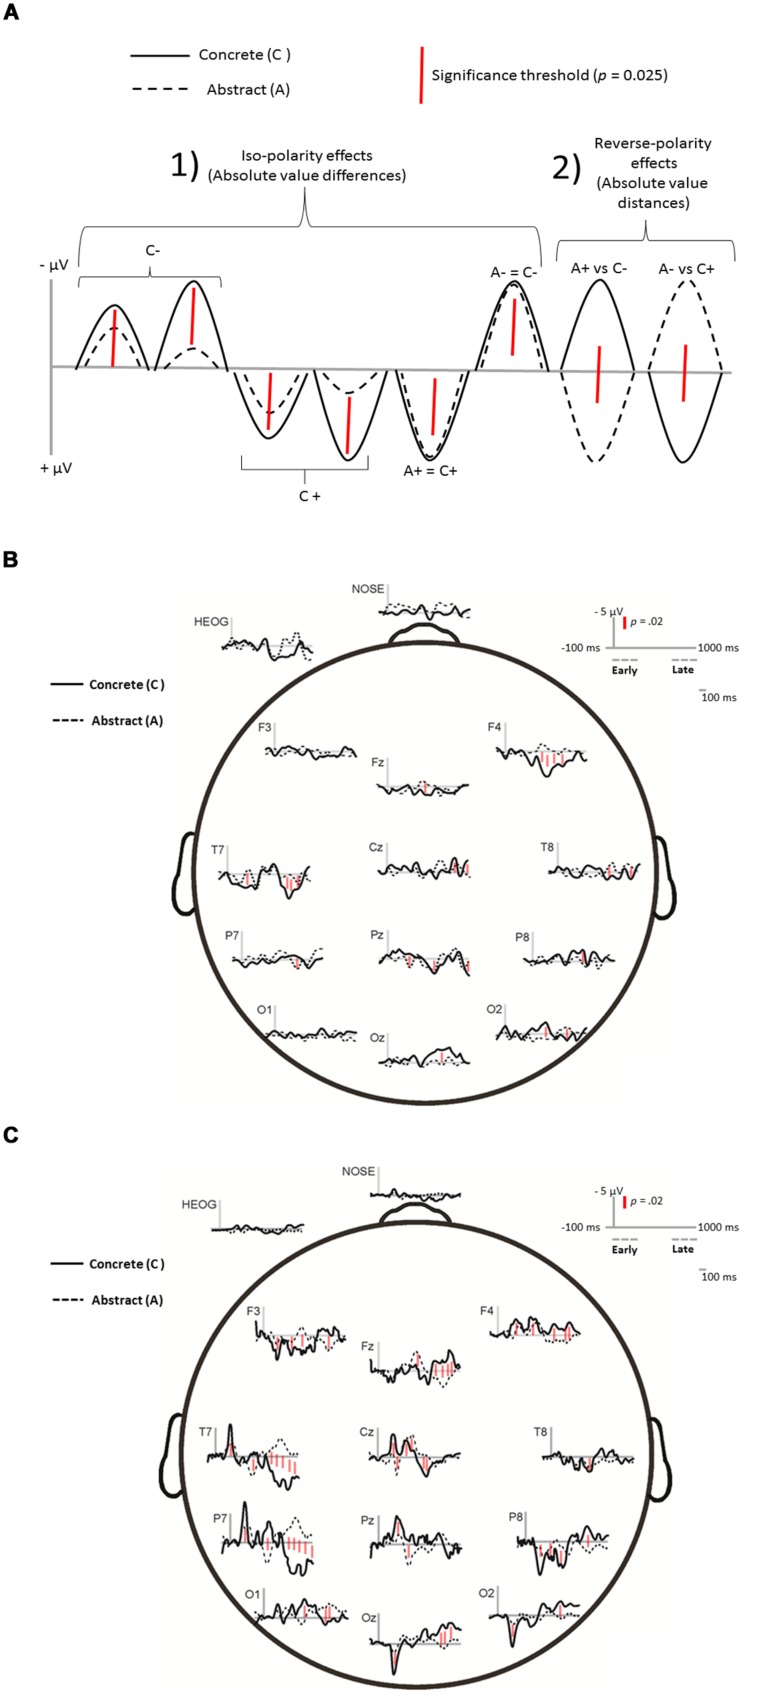
(A) Study of waveform differences and homologies empirically observed for ERP activity in response to concrete and abstract words. To quantify distances shown in the waves, the Iso-polarity effects involved computing the differences in absolute values, whereas reverse polarity effects involved computing the sum of absolute values. The significance threshold shown as red distance-bar was corrected for multiple comparison testing using the Simes–Bonferroni procedure (see text). Grand average ERP waveforms for concrete and abstract words conditions in the auditory (B) and visual parts (C) of the WVT. The magnitude of the minimum significant effect is represented as a red distance-bar (drawn in scale with respect to 5 μV). Distances/differences larger than the red bar were significant at least at p < 0.05, as examples, main points of significance are marked with the red bar in the waveforms.